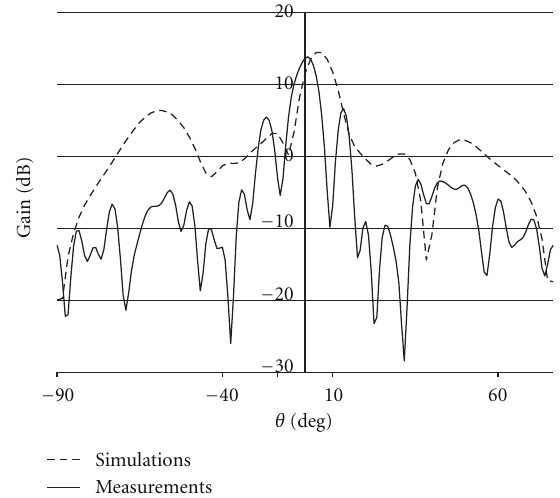
Figure 7: Radiation pattern on plane B ( ϕ = 90 ◦ , θ j ( − 90 ◦ ≤ θ j ≤ 90 ◦ )).